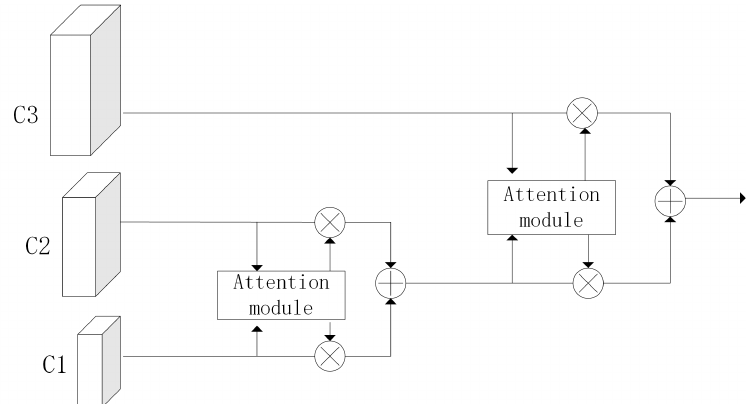
Figure 5. Multi-scale adaptive fusion structure, where C1, C2 and C3 represent the costs of different scales and ⊗ stands for the multiplication operation.